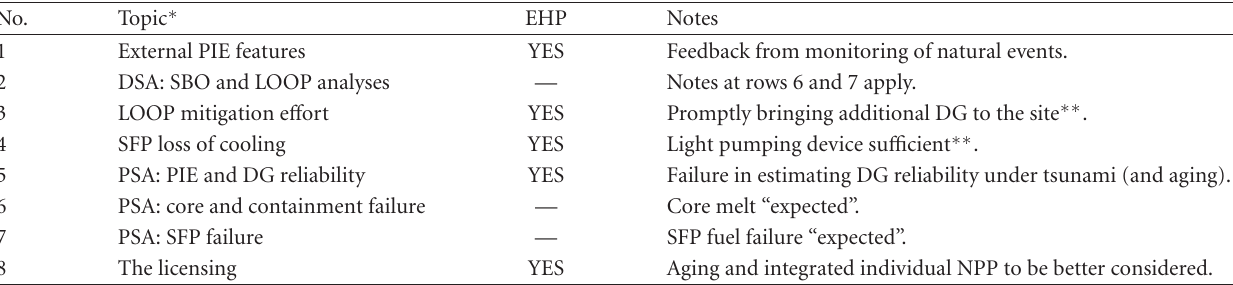
Table 9: Summary of background for the Fukushima Daiichi